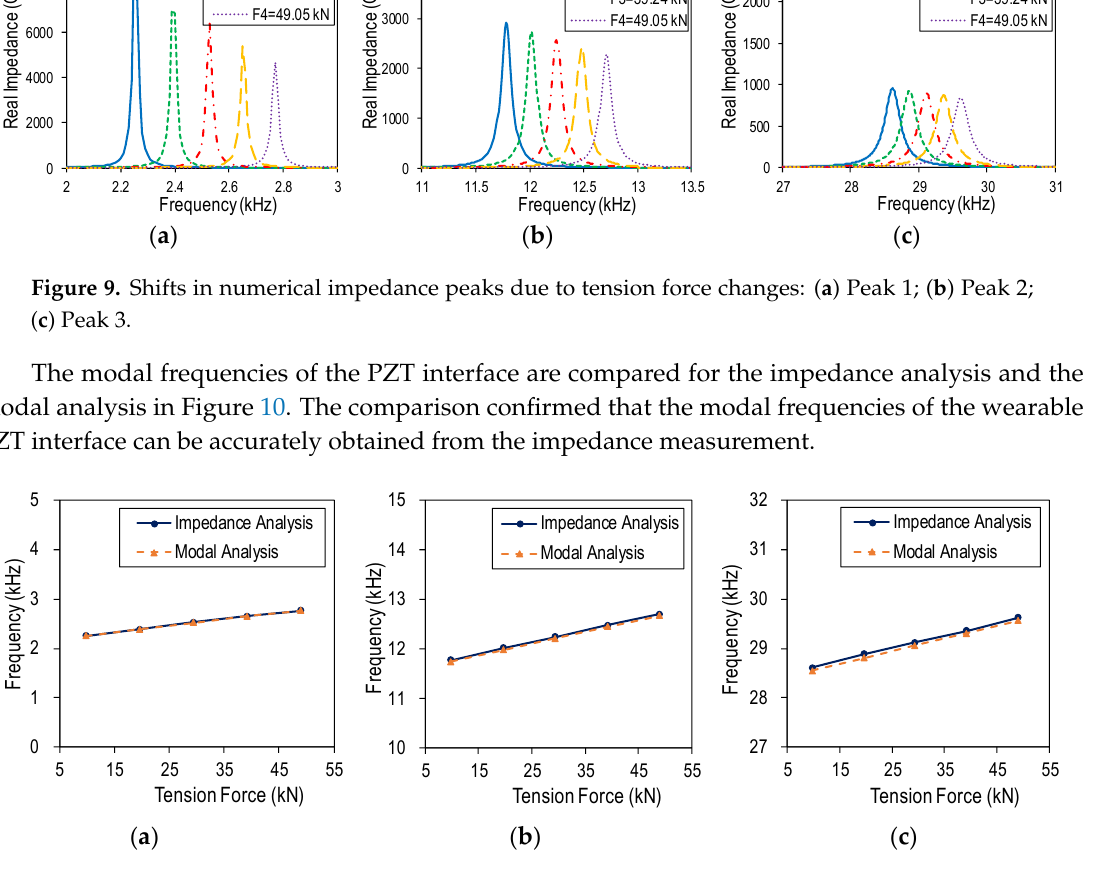
Figure 8. Numerical impedance signatures of wearable PZT interface under different tension forces.